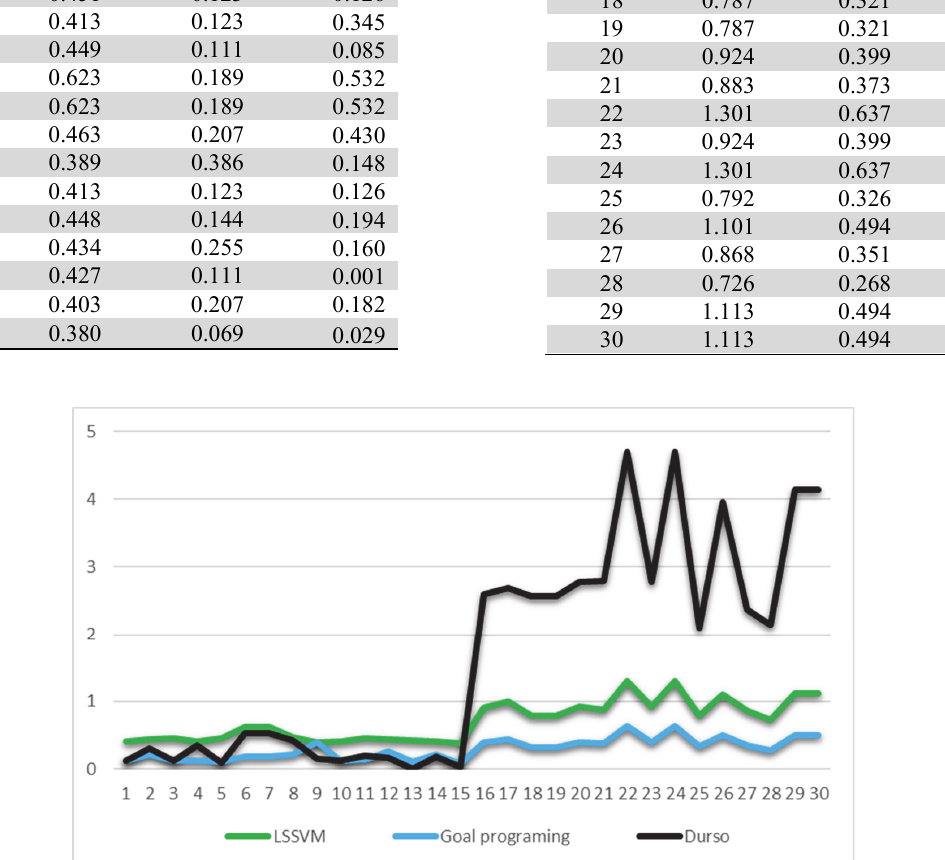
Fig. 2. Performance of the